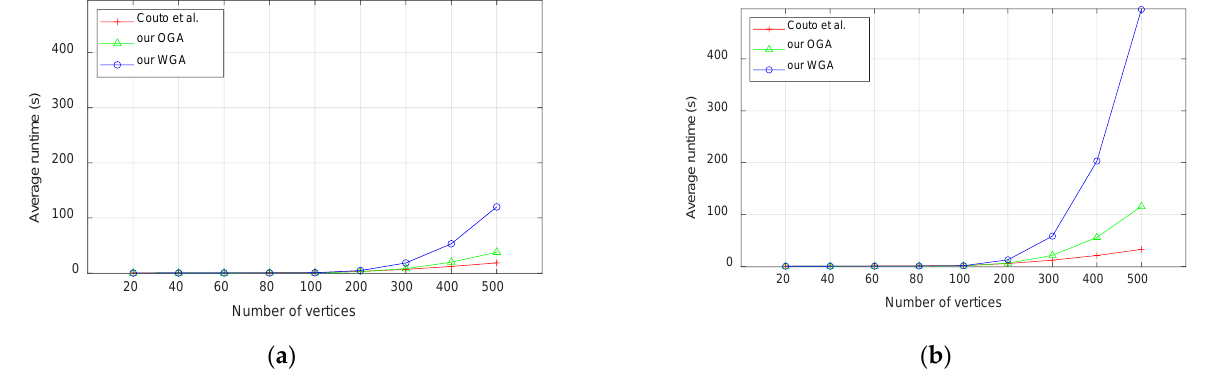
Figure 11. Average runtime in reaching the optimality for ( a ) random orthogonal polygons; ( b ) ran- dom simple polygons. (Direct comparison is not possible due to different computation environ- ments.)